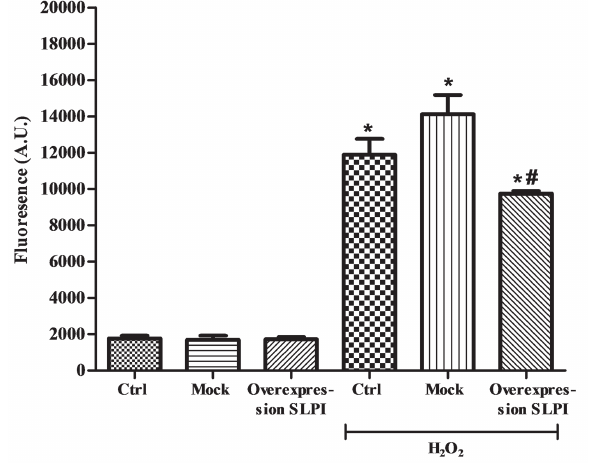
Figure 3: Determination of cellular ROS level of the stable H9c2 cell lines overexpressing rhSLPI challenging with H were incubated with carboxy-H2DCFDA. After incubation, H applied to each cell group and the cellular ROS level was determined spectrophotometrically. Each bar graph represents the means ± S.E.M for each of the three experiments. * p < 0.05 vs control cell (ANOVA) and # p < 0.05 among H